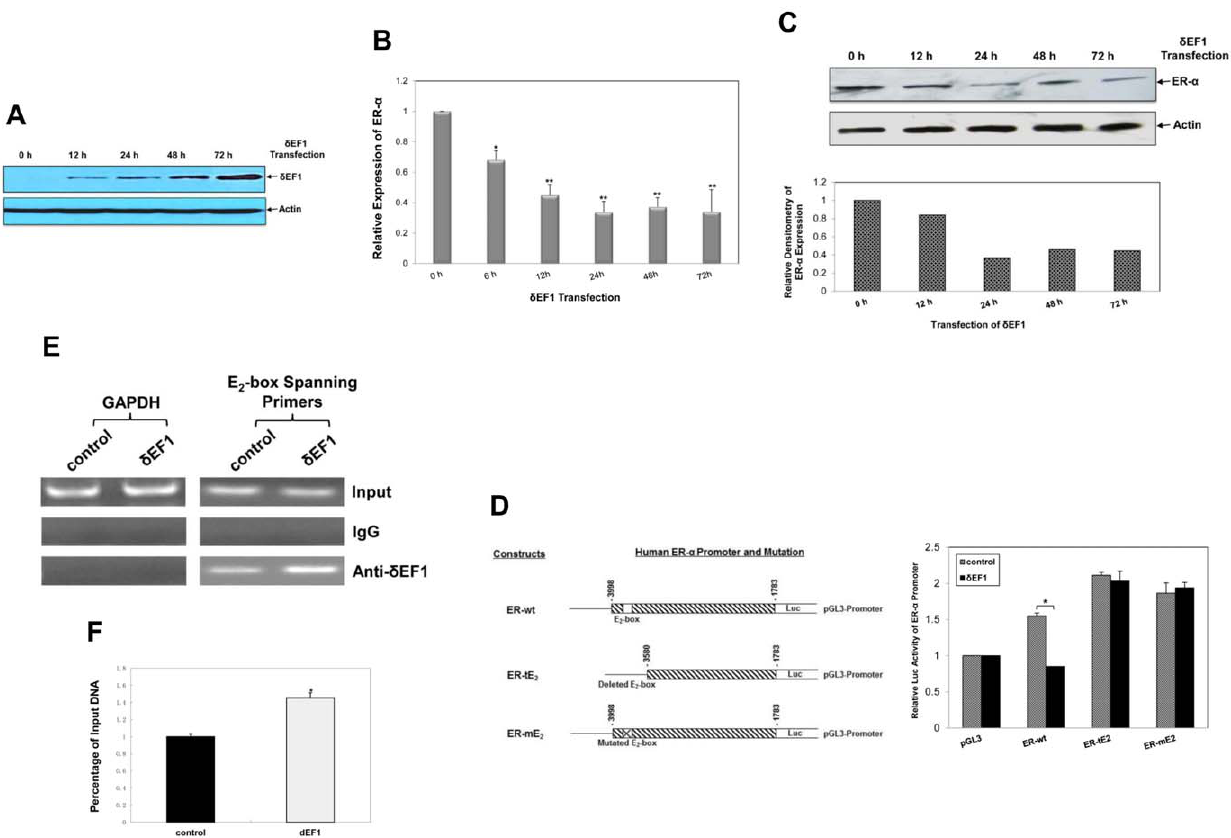
Figure 4. Ectopic expression of d EF1 represses ER- a transcription by binding to E 2 -box on its promoter. A. The d EF1 expression plasmid was transiently transfected into MCF-7 cells. At the indicated time points following transfection, the expression of d EF1 protein was verified by Western Blot. Actin was used to normalize the ER- a level. B. MCF-7 cells were transiently transfected with the d EF1 expression plasmid. At the indicated time points following transfection, the down-regulation of ER- a mRNA was verified by Q-PCR. GAPDH was used to normalize the ER- a level. * indicates p , 0.05 in unpaired Student’s t-test compared with control. ** indicates p , 0.01 in unpaired Student’s t-test compared with control. The data represent three independent experiments. C. MCF-7 cells were transiently transfected with the d EF1 expression plasmid. At the indicated time points following transfection, the expression of ER- a protein was examined by Western Blot. Actin was used to normalize the ER- a level. D. Sequential deletion (ER-tE 2 ) and mutation (ER-mE 2 ) of E 2 -box on the human ER- a promoter were fused to the luciferase reporter. MCF-7 cells on 24-well plates were co-transfected with the d EF1 expression plasmid (1 m g/well) or wild-type (ER-wt), truncated (ER-tE 2 ), or mutated (ER-mE 2 ) ER- a promoter luciferase reporter constructs (1 m g/well). The luciferase activities of the extracts were determined at 24 h following transfection using a Betascope analyzer. The luciferase values are normalized with constitutive Renilla activities. * indicates p , 0.05 in unpaired Student’s t-test compared with control. The data represent three independent experiments. E. The association of d EF1 with the ER- a promoter was assessed by ChIP analysis in MCF- 7 cells using a polyclonal antibody against d EF1 or an unrelated IgG antibody. The amplified ER- a promoter fragment of the E 2 -box-containing sequence is shown. The amount of DNA in the input lane confirms the equal loading of chromatin. F. d EF1 transfection significantly enhanced its recruitment to the endogenous ER- a promoter by quantitative ChIP analysis. * indicates p , 0.05 in unpaired Student’s t-test compared with vector alone. The data represent three independent experiments.